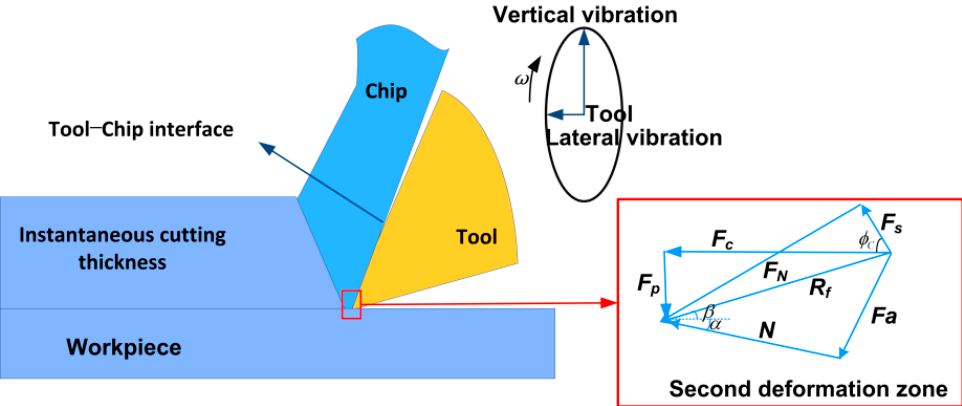
Equations (1) and (2) show that the friction mechanism in EVC is different from conventional turning and is more complicated due to the effects of vibration and tool tip trajectory. The friction force is changed to a time-varying function at time t due to the effects of vibration and tool tip trajectory. In order to model cutting forces, a vector decomposition analysis of the cutting forces is necessary. Due to the lateral vibration, the surface crack of the workpiece contacted by the rake face is deeper and longer than the cutting length, and the actual shear angle increases.